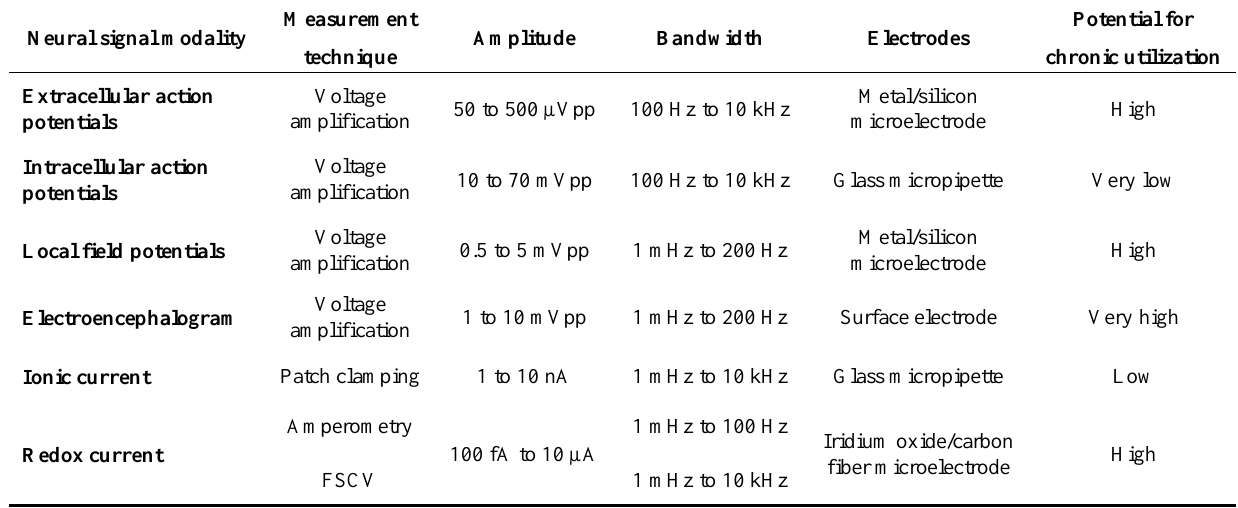
Table 1. Summary of Neural Recording Parameters for Different Signal